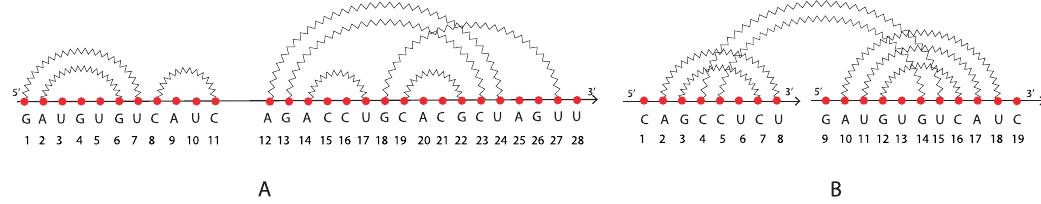
Figure 1: On the right (A), the diagram of an RNA secondary structure, on the left (B) an RNA–RNA interaction structure.